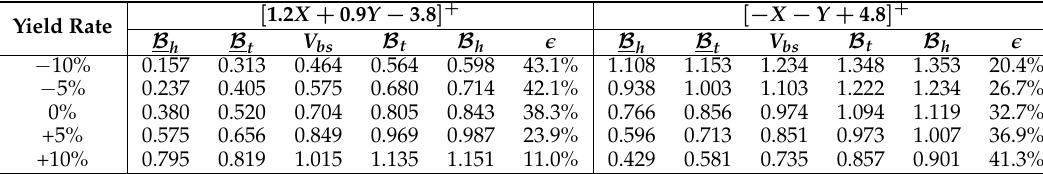
Table 5. Sensitivity of Valuation Bounds Against Yield Rate. The time-zero prices of the exchange rates X and Y are 1.6 and 2.5. The volatilities of the processes X and Y are 42%, and two processes are correlated with ρ = 0.20. The yield rate ( δ ) is the difference between the domestic risk-free interest rate ( r $ − r f . The domestic interest rate is set by 2%, and the foreign interest rates for the Euro ( X ) and Pound ( Y ) i.e., δ = r $ d are assumed to be identical.All prices are attained within a price mesh of u = 1.12 and J = 30. Two basket options mature at T = 1 (year), and thus the discount factor is expressed as DF = e − r $ d T = 0.98. Yield